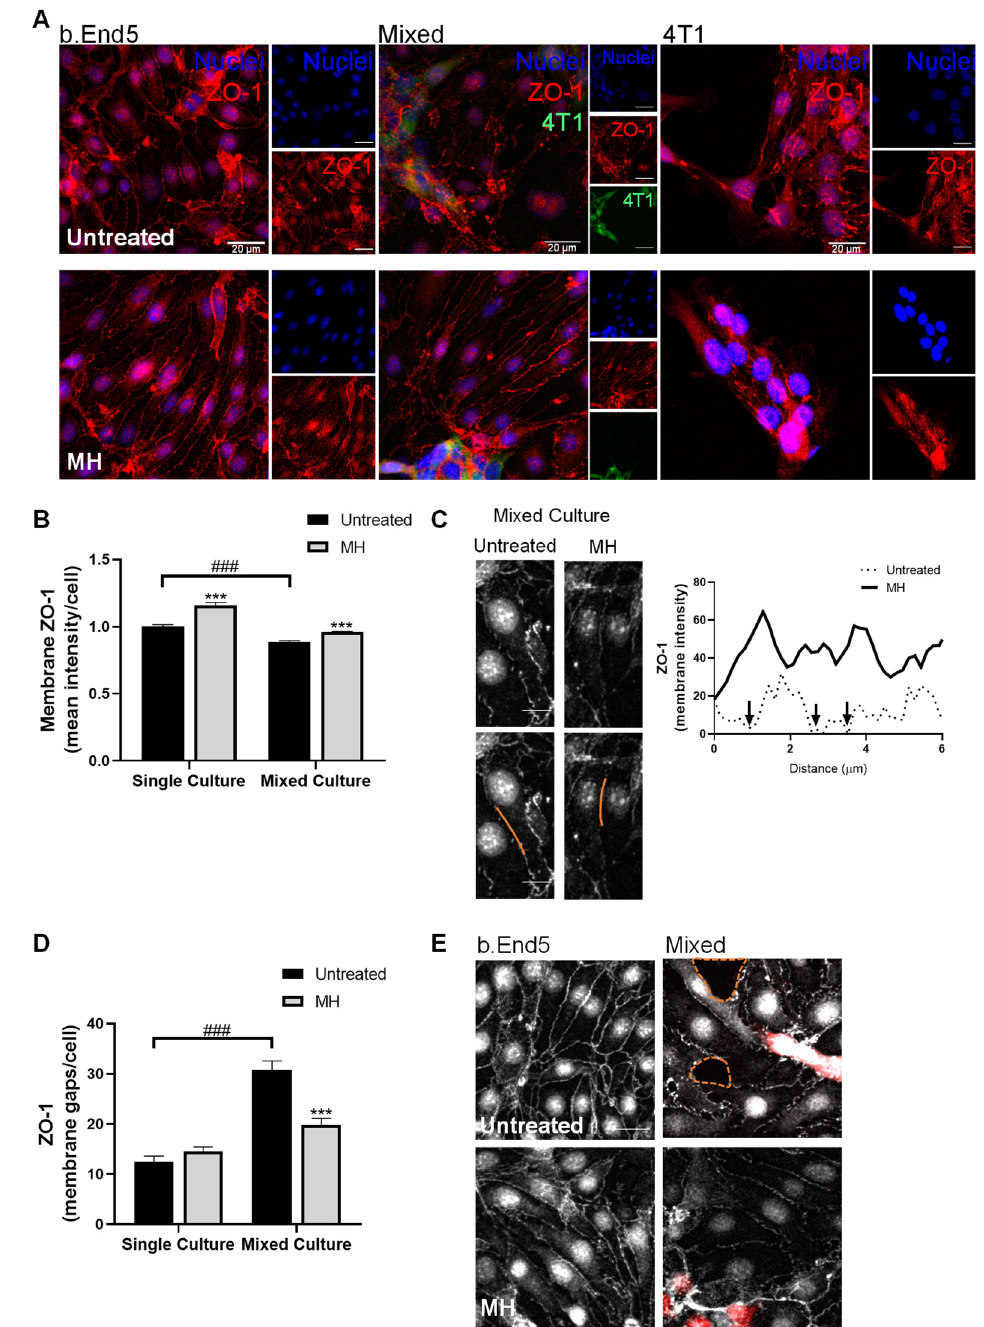
Figure 8. MH protects endothelial junctional properties. Confluent monolayers of b.End5 cells under physiological laminar non-pulsatile shear stress were exposed to 4T1 cells (previously labelled with CellTracker™ CMFDA Green Dye) and treated with MH (1 µ M), or DMEM (untreated), for 24 h, and the expression of the TJs protein, ZO-1 (red), in single and mixed cultures, was evaluated by immunofluorescence analysis. ( A ) ZO-1 staining highlighted a clear expression in b.End5, particularly in cells treated with MH. Hoechst 33342 was used as counterstaining for nuclei (blue). Scale bar: 20 µ m. ( B ) Semi-quantitative analysis showed an increase in membrane ZO-1 in b.End5 cells in single culture and that the contact with 4T1 cells induced a decrease, which was avoided by MH treatment. ( C ) Analysis of membrane ZO-1 expression (grey) in the orange region of the b.End5 cells in